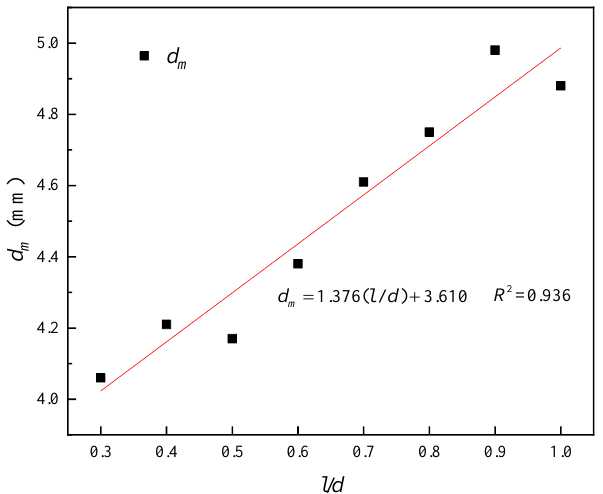
Figure 10. The relationship between the average particle size, d m, of coal fragments and l / d . Although the fact that the average particle size quantitatively reflects the total degree of fragmentation, it overlooks the general features of the fragmentation size distribution. As a result, the fractal theory was utilized to analyze the fragmentation of the specimen to explain the distribution features of the fragmentation. The logarithmic curve of particle mass distribution of various ratio fragmentation fractals is shown in Figure 11. According to the sample’s fragmentation distribution law, the correlation coefficient of the coal specimen’s fragmentation distribution is more than 0.97, indicating a high degree of self-similarity.